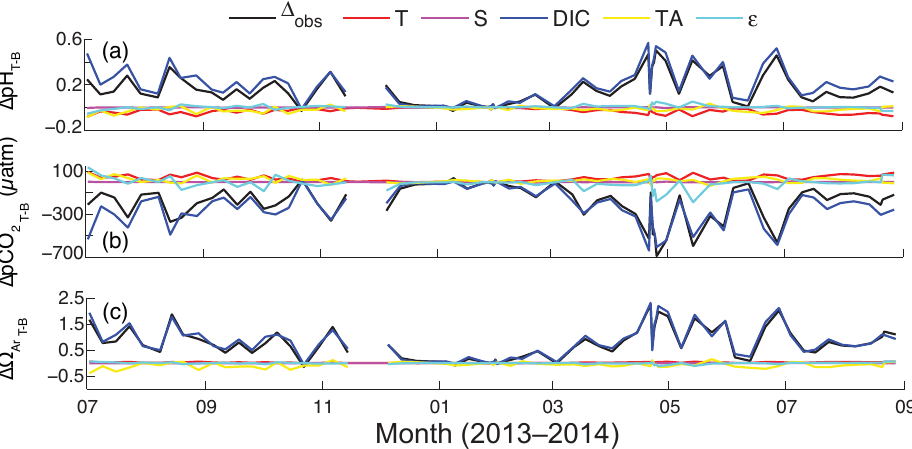
Figure 7. Observed (black) surface-to-bottom differences in (a) pH, (b) p CO 2 , and (c) (cid:127) Ar at the Protected Offshore site along with the calculated contributions of temperature (red), salinity (magenta), DIC (blue), and TA (yellow) to the observed carbon system gradients. The residual difference between the observed and calculated contributions is shown in